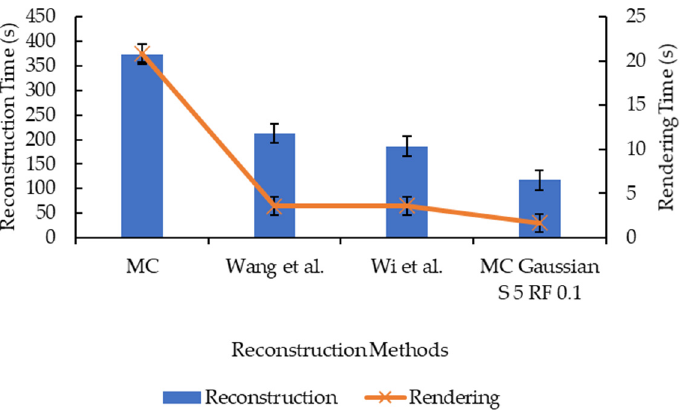
Figure 20. Graph of reconstruction and rendering time against different reconstruction methods.